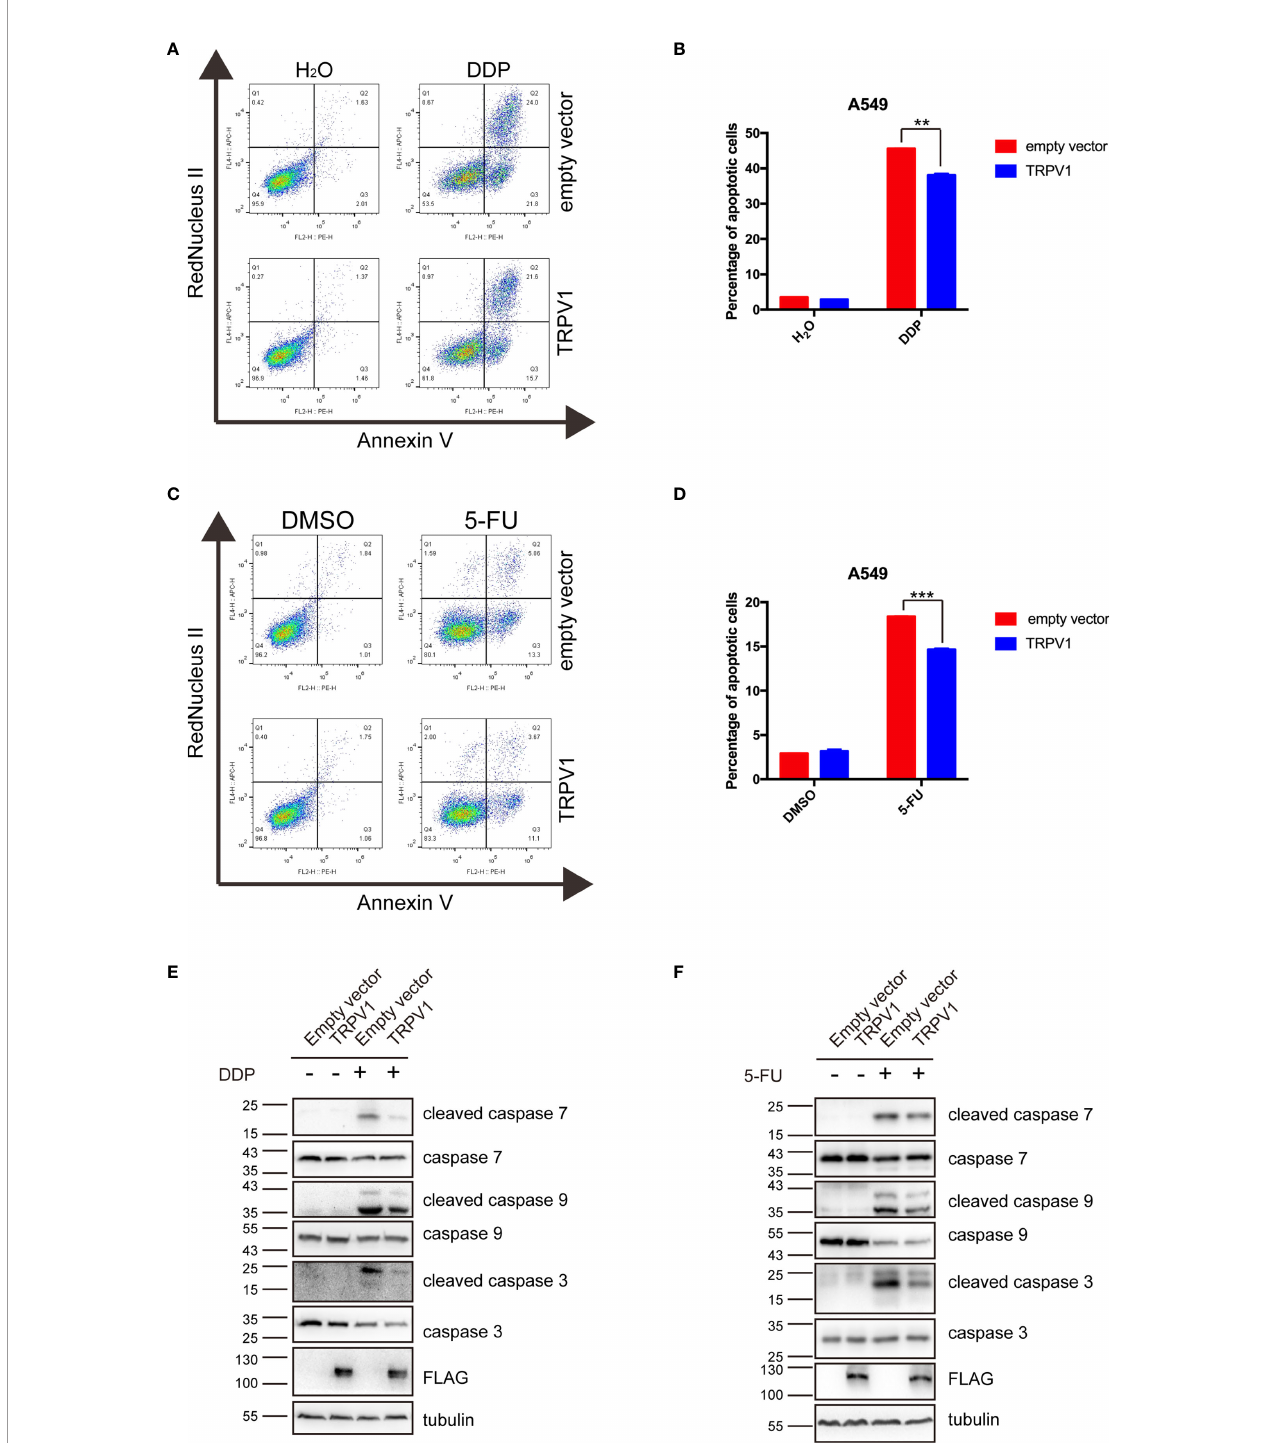
FIGURE 7 | TRPV1 overexpression alleviated apoptosis induced by DDP and 5-FU. (A) Flow cytometric analysis showing that TRPV1 overexpression attenuated apoptosis induced by DDP treatment (20 m M) for 24 h. (B) Statistical analysis of (A) . (C) Flow cytometric analysis showing that TRPV1 overexpression attenuated apoptosis induced by 5-FU treatment (160 m g/mL) for 24 h. (D) Statistical analysis of (C) . (E) Western blot analysis showing that TRPV1 overexpression decreased the levels of cleaved caspase 7, 9 and 3 proteins induced by DDP treatment (20 m M) for 24 h; b -tubulin served as the loading control. (F) Western blot analysis showing that TRPV1 overexpression decreased the levels of cleaved caspase 7, 9 and 3 proteins level induced by 5-FU treatment (160 m g/mL) for 24 h; b -tubulin served as the loading control. Three independent experiments were performed. Data represent mean ± SEM; ** P < 0.01. *** P <